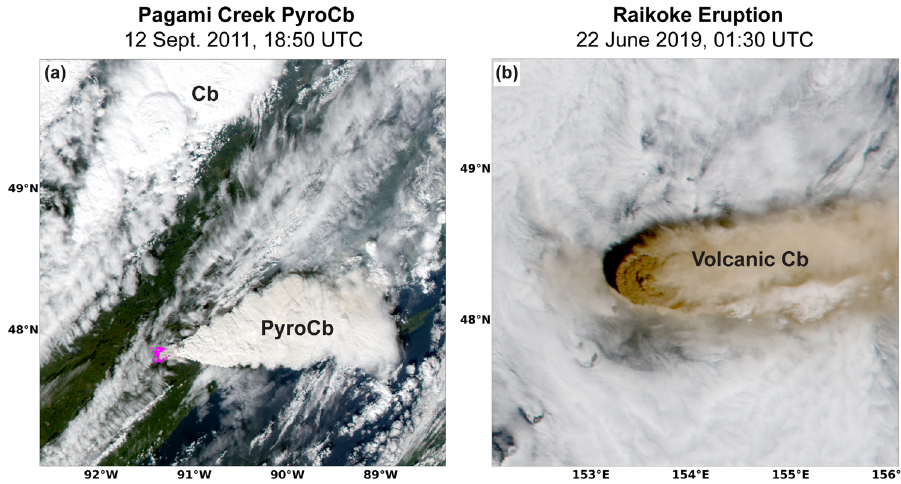
Fig. 1 Visual comparison between three types of overshooting thunderstorm convection. True color imagery highlights ( a ) traditional Cb and pyroCb using Aqua MODIS and ( b ) volcanic Cb using Terra MODIS. The pyroCb was spawned by the Pagami Creek fi re along the border of Ontario, Canada and Minnesota, USA, on 12 September 2011. For a witness/survivor account, see https://queticosuperior.org/blog/video-tells-riveting-story-of-six-rangers- caught-by-pagami-creek- fi re/. MODIS fi re detections are displayed in pink. The volcanic Cb is from the Raikoke volcanic eruption on 22 June 2019 in the Kuril Islands of